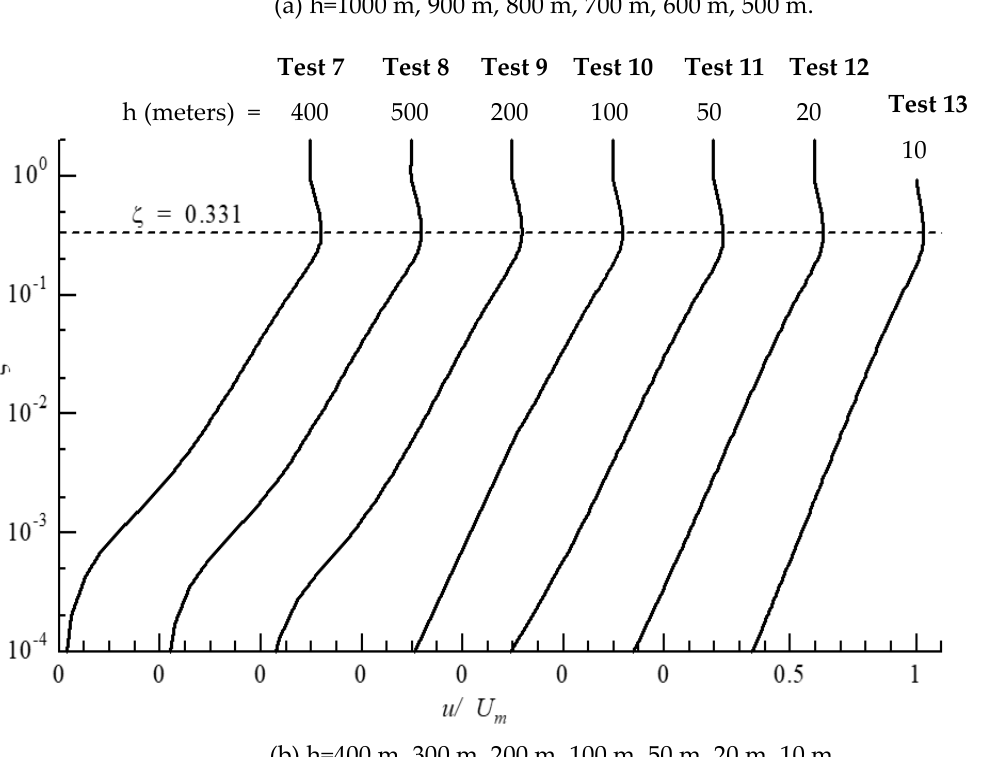
Figure 6. Velocity profile at 𝜎𝑡 = 0 from k- 𝜔 model computations. ( a ) h = 1000 m, 900 m, 800 m, 700 m, 600 m, 500 m. ( b ) h = 400 m, 300 m, 200 m, 100 m, 50 m, 20 m, 10 m.